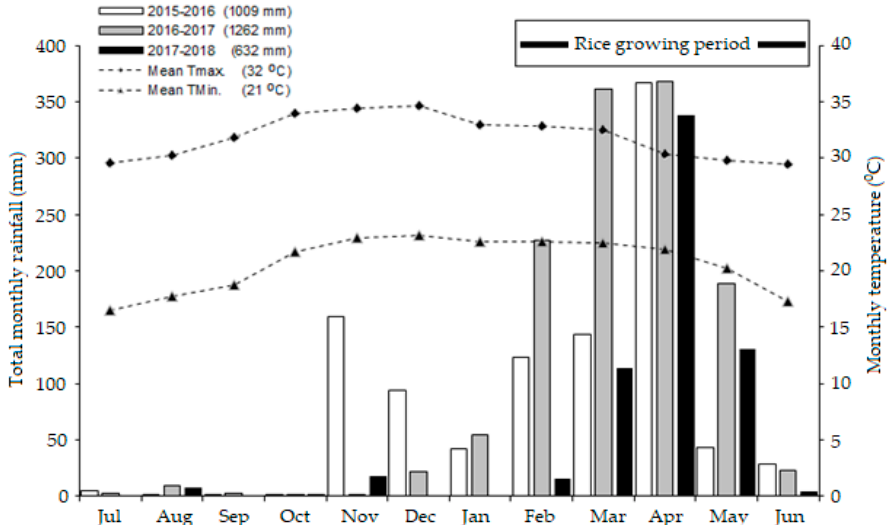
Figure 1. Monthly and total annual rainfall and mean minimum and maximum air temperature distribution during the three-year experimental period. Data were recorded at a weather station installed at Ifakara Health Institute research station, about 5 km West of Ifakara town.